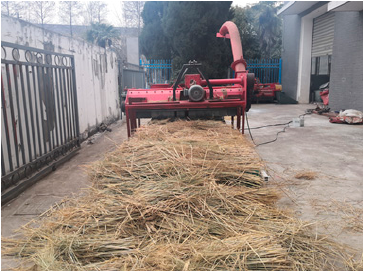
Figure 5. Test site of rice straw crushing and scattering system .